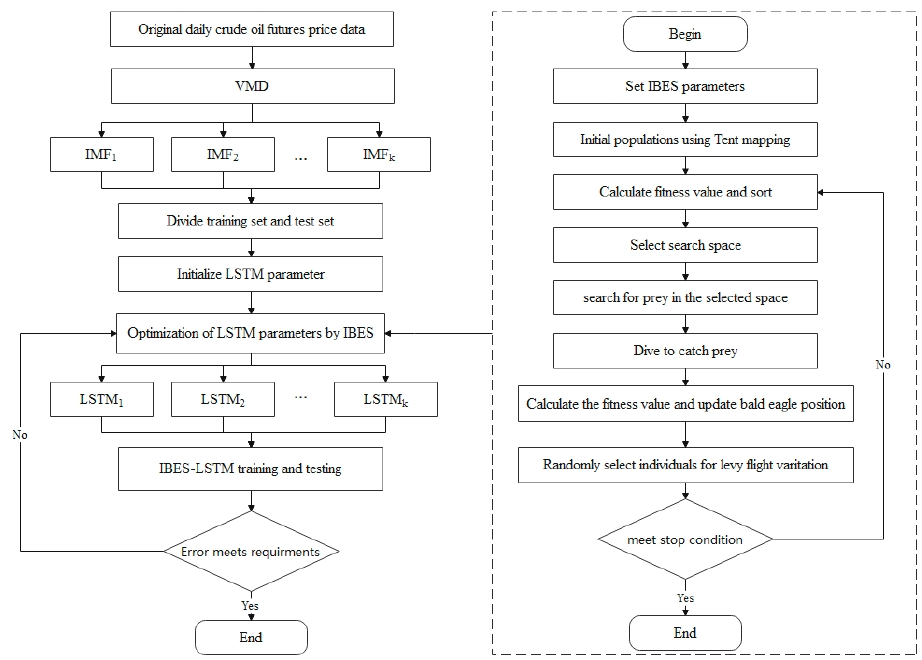
Figure 2. Flow chart of VMD-IBES-LSTM model.